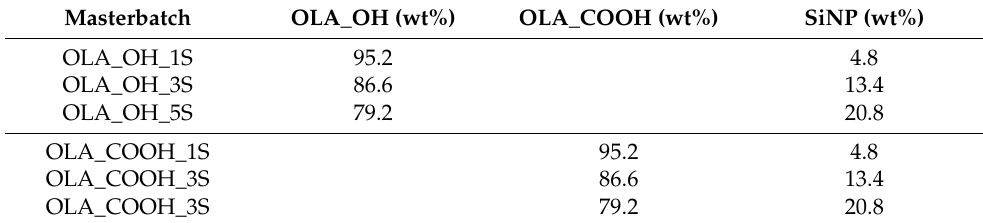
Table 1. Composition of OLA/silica masterbatches.